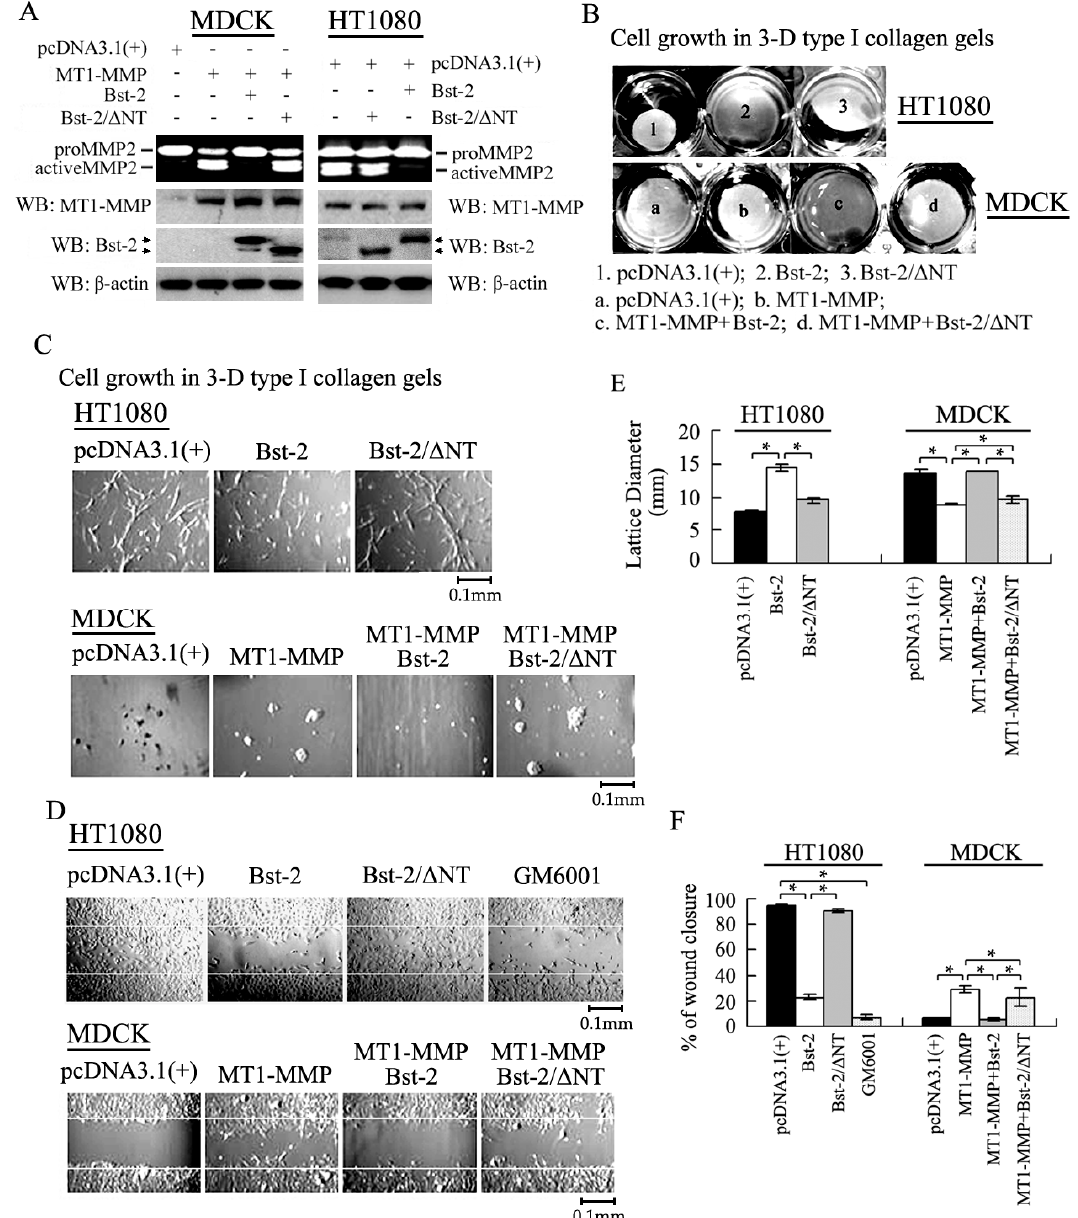
Figure 6. Effect of the N-terminal domain of Bst-2 on MT1-MMP activity and MT1-MMP-promoted cell growth and migration. MDCK cells and HT1080 cells were seeded in 6-well plates overnight and transfected as described in figures; ( A ) 24 h after transfection, medium were changed into DMEM with 5% FBS; another 24 h later, culture medium were collected and centrifuged at 12,000 rpm for 10 min, and then subjected to zymography gel assay; then, cells were harvested and lysed for Western-blot assay; ( B , C ) also 24 h after transfection, the culture containing the same amount of cells (1 × 10 3 ) was mixed with 500 mL of type I collagen (2.5 mg/mL) and allowed to gel at 37 °C in 24-well plates to give rise to three-dimensional collagen lattice; it was then cultured with new medium for one week. The gel lattices containing cells and cells grown in gel lattice were photographed with a video camera; ( D ) after transfected HT1080 and MDCK cells growing to almost confluency in 6-well plates; a scratch wound assay was employed to check the effect of wide type Bst-2 and Bst-2/ Δ NT on cellular migration ability induced by MT1-MMP; ( E , F ) the quantification of the 3-D gel lattices (lattice diameter) in ( B ) and the percentages of wound closure in wound healing assays (the quantification of wound healing assays) in ( D ). Error bars indicate s.d. among three individual experiments. * p < 0.05.